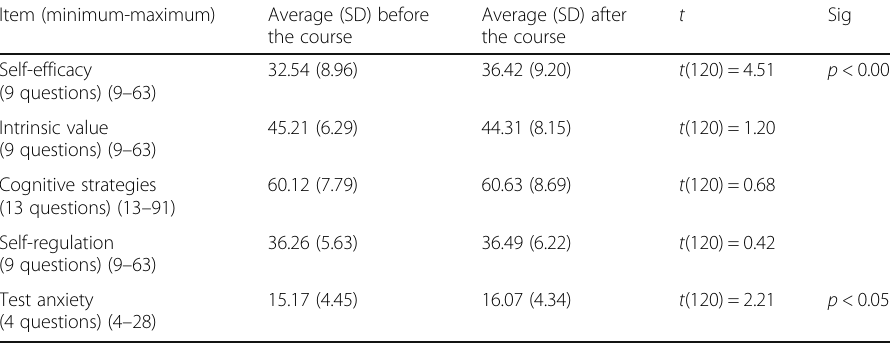
Average (SD) after t Sig the course the course 32.54 (8.96) 36.42 (9.20) t (120) = 4.51 p < 0.001